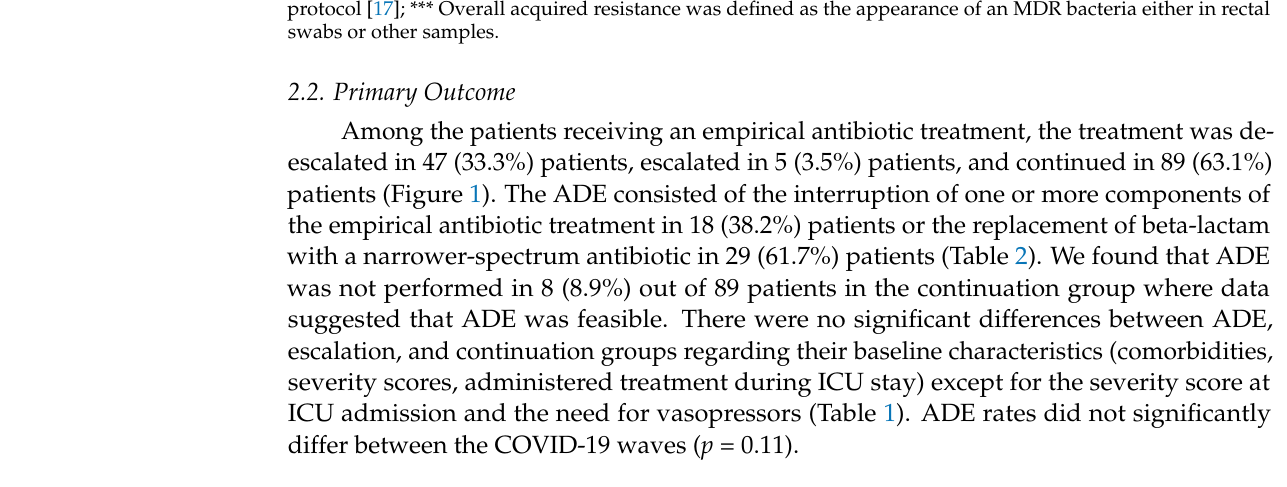
Table 2. Motivations for ADE in the COVID-19